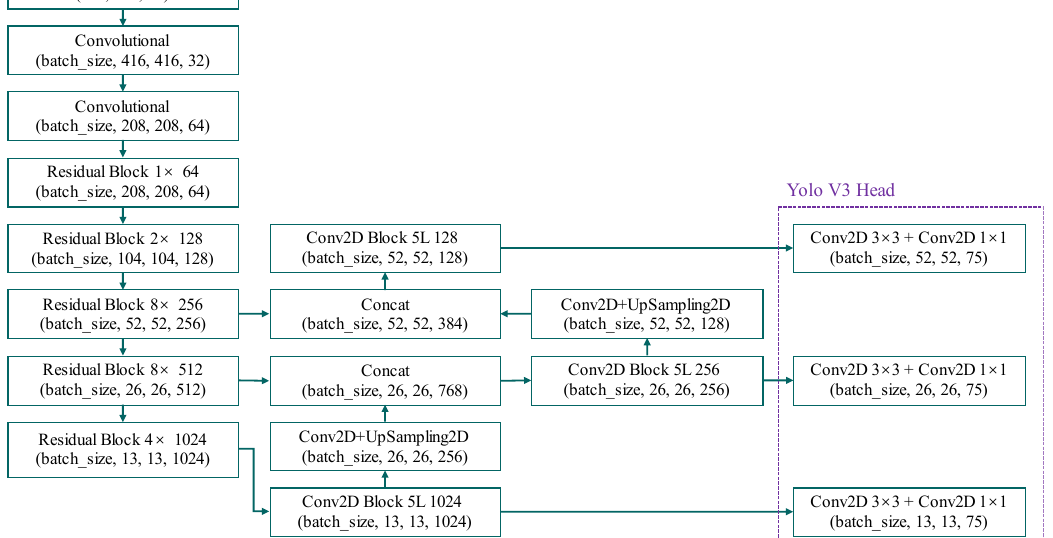
Figure 9. YoloV3 network structure.